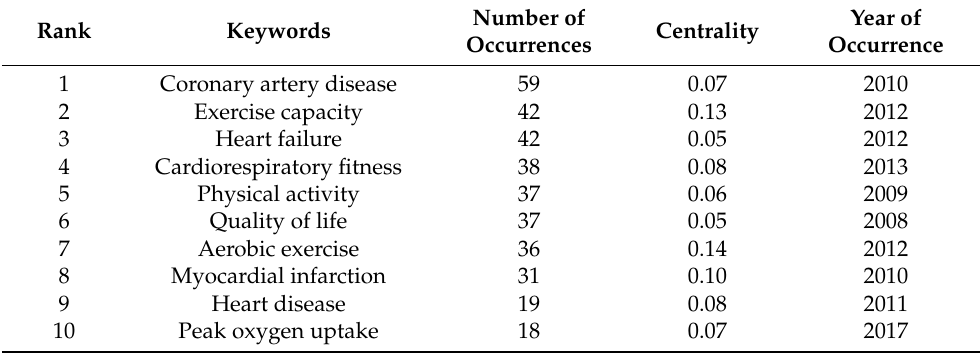
Figure 5. Keyword co-occurrence knowledge map. Table 6. Top 10 keywords co-occurrence frequency.